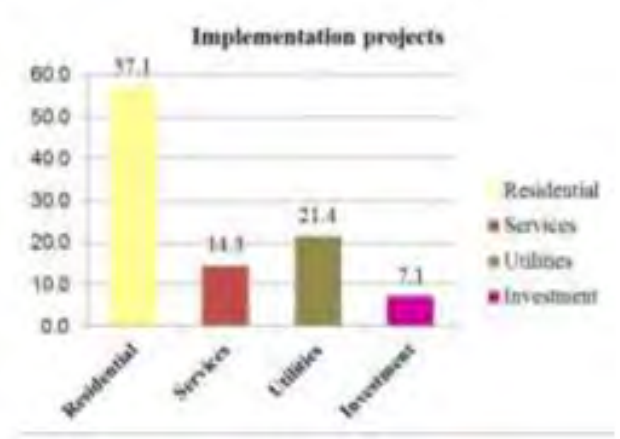
Figure 1. Implementation ofpriority projects